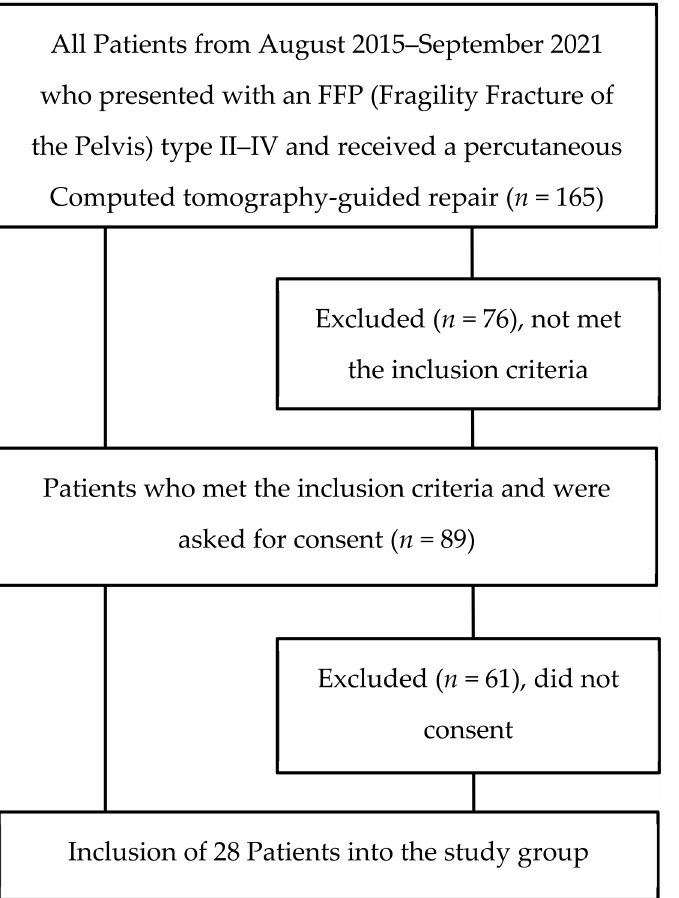
Figure 1. Consort